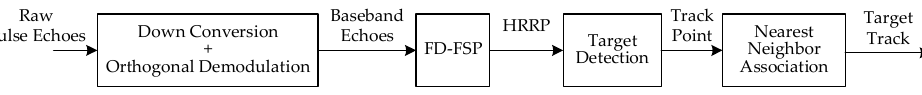
Figure 3. Signal processing of the high-resolution coherent VLR.